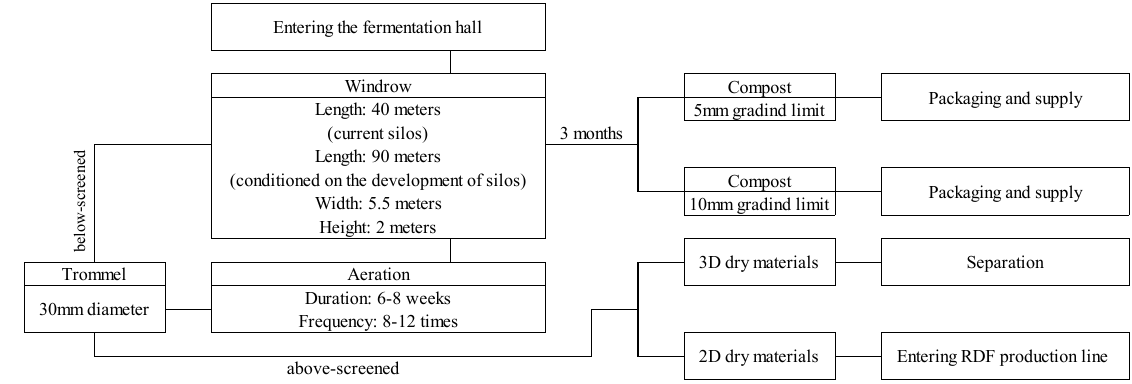
Figure 3 . The diagram of the proposed process for fermentation phase and waste aeration.